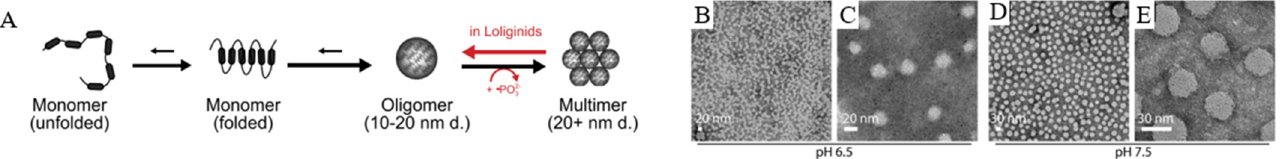
Figure 2. ( A ) Net charge neutralized progressive and reversible hierarchical assembly driven by pH-titration (in vitro) or phosphorylation (in vivo) [14]. Copyright 2017, AIP Publishing LLC. ( B – E ) TEMs of reflectin A1 assemblies at pH6.5 and pH7.5 at low and high magnifications [38]. Copyright 2015, American Society for Biochemistry and Molecular Biology.